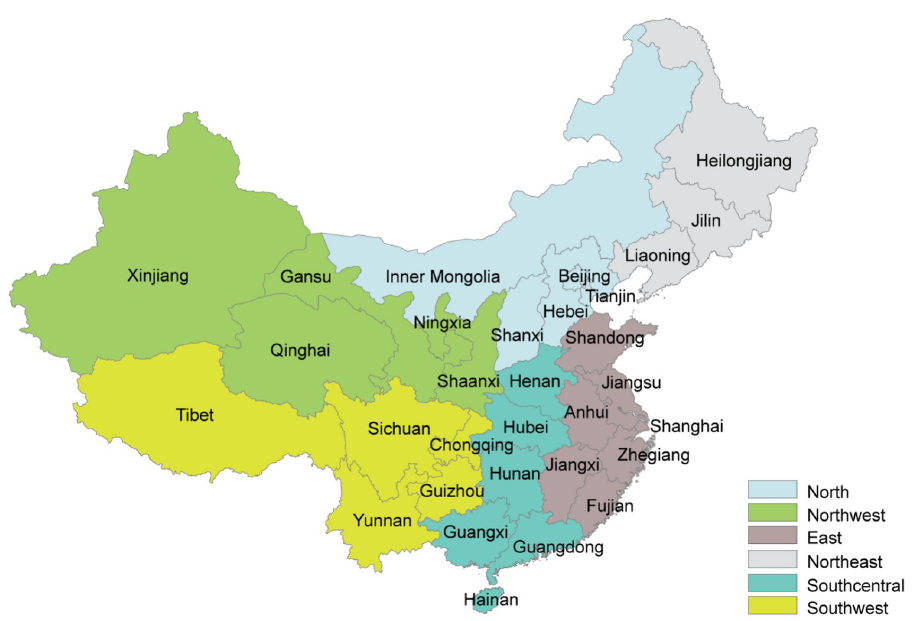
Fig 6. Map of the 31 provinces and the 6 regions of